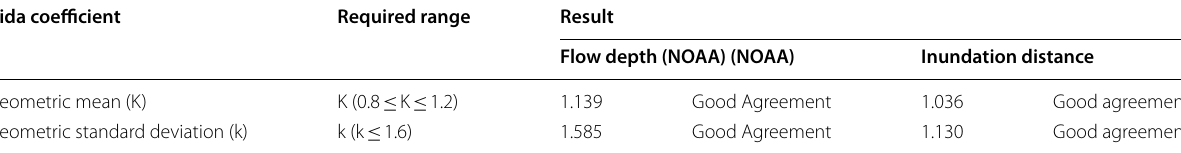
Table 2 Validation of tsunami height and inundation distance Aida coefficient Required